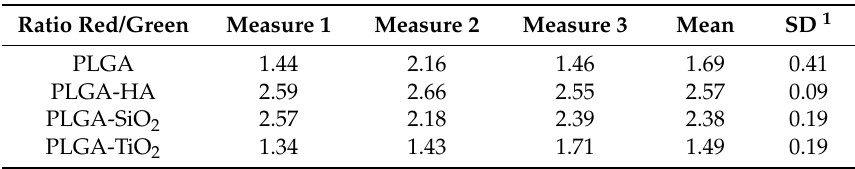
Table 1. The means and standard deviation of the ratio of the red/green fluorescence on the cells adhered in the studied membranes are shown.